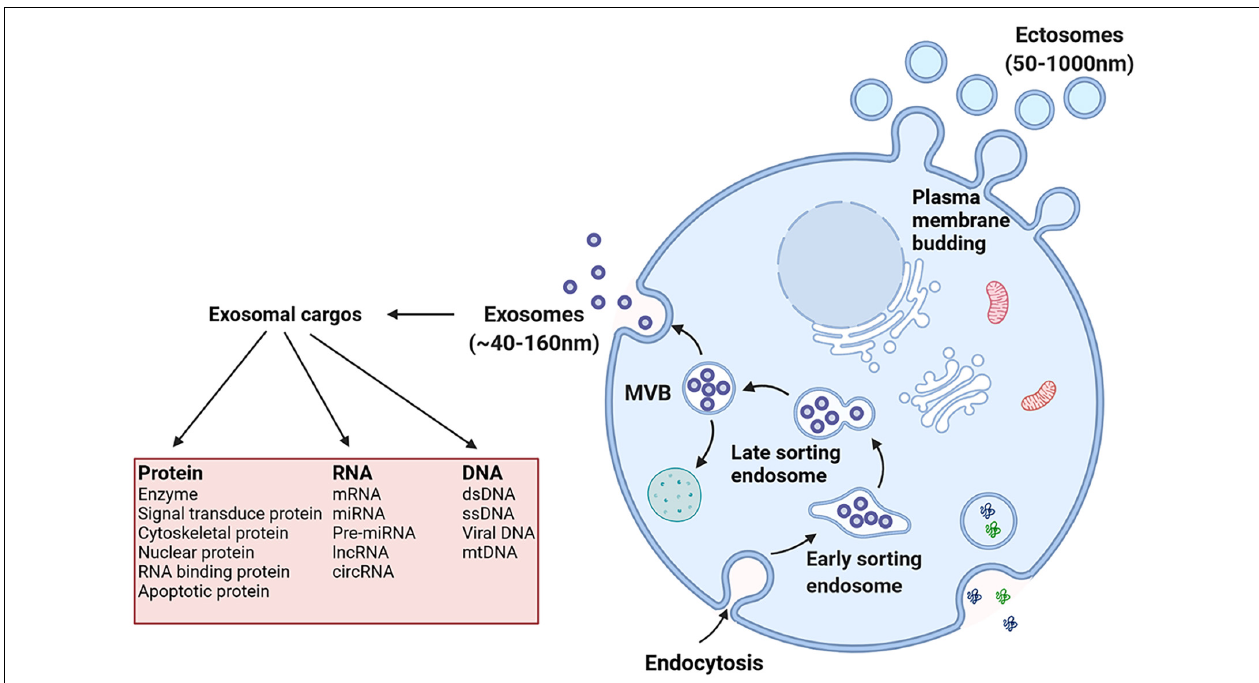
FIGURE 1 | Exosomes originate from the endosomal pathway by the formation of the early sorting endosome (ESEs), late sorting endosome (LSEs), and ultimately multivesicular bodies (MVBs), which contain intraluminal vesicles (ILVs). Then MVBs fuse with the plasma membrane and exosomes are released. And exosomal cargoes include various types of biological molecules, such as protein, RNA and